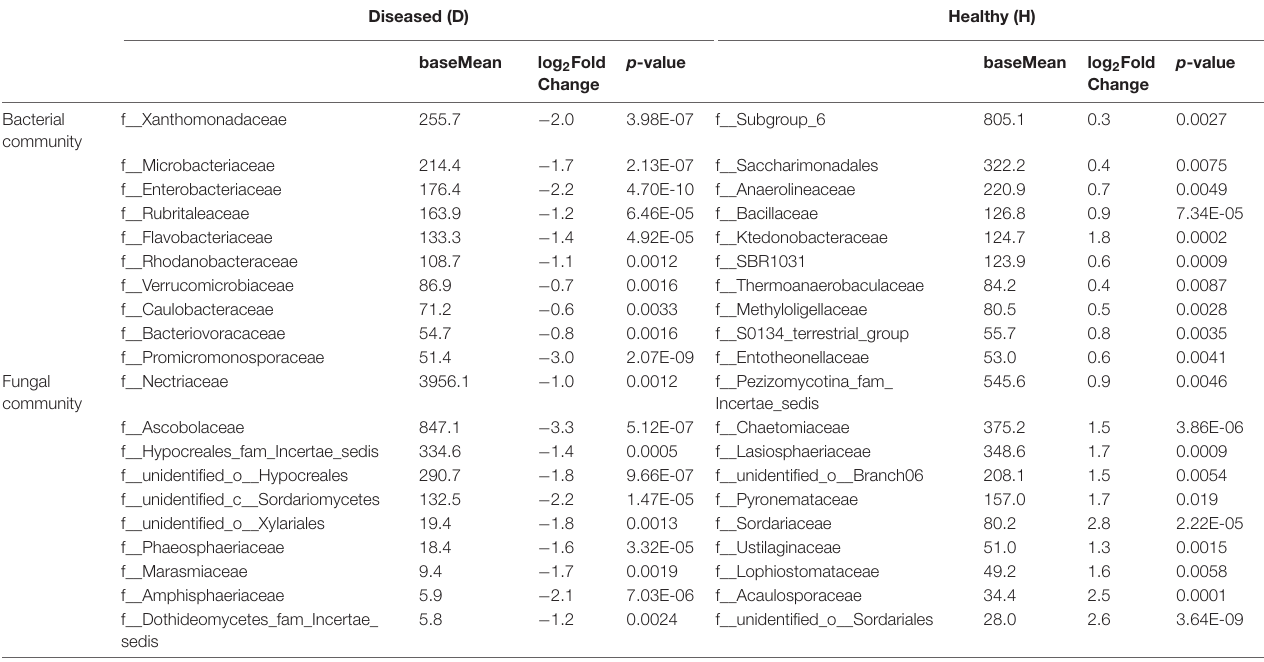
TABLE 2 | Selected differential abundance of bacterial and fungal family taxa in healthy and diseased roselle rhizospheres. Diseased (D) Healthy (H) baseMean